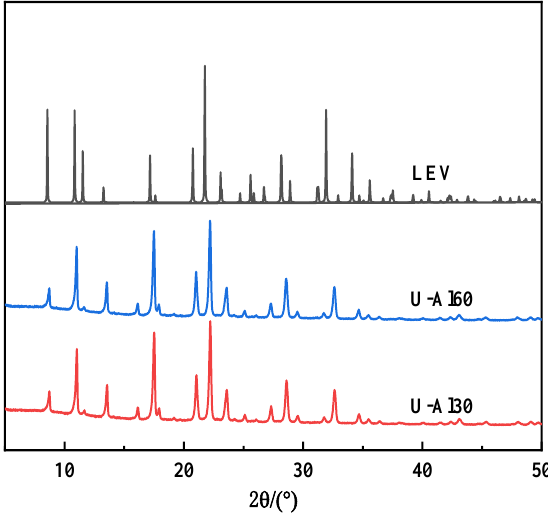
Figure 1. The XRD pattern of samples with n (SiO 2 )/ n (Al 2 O 3 ) = 30.